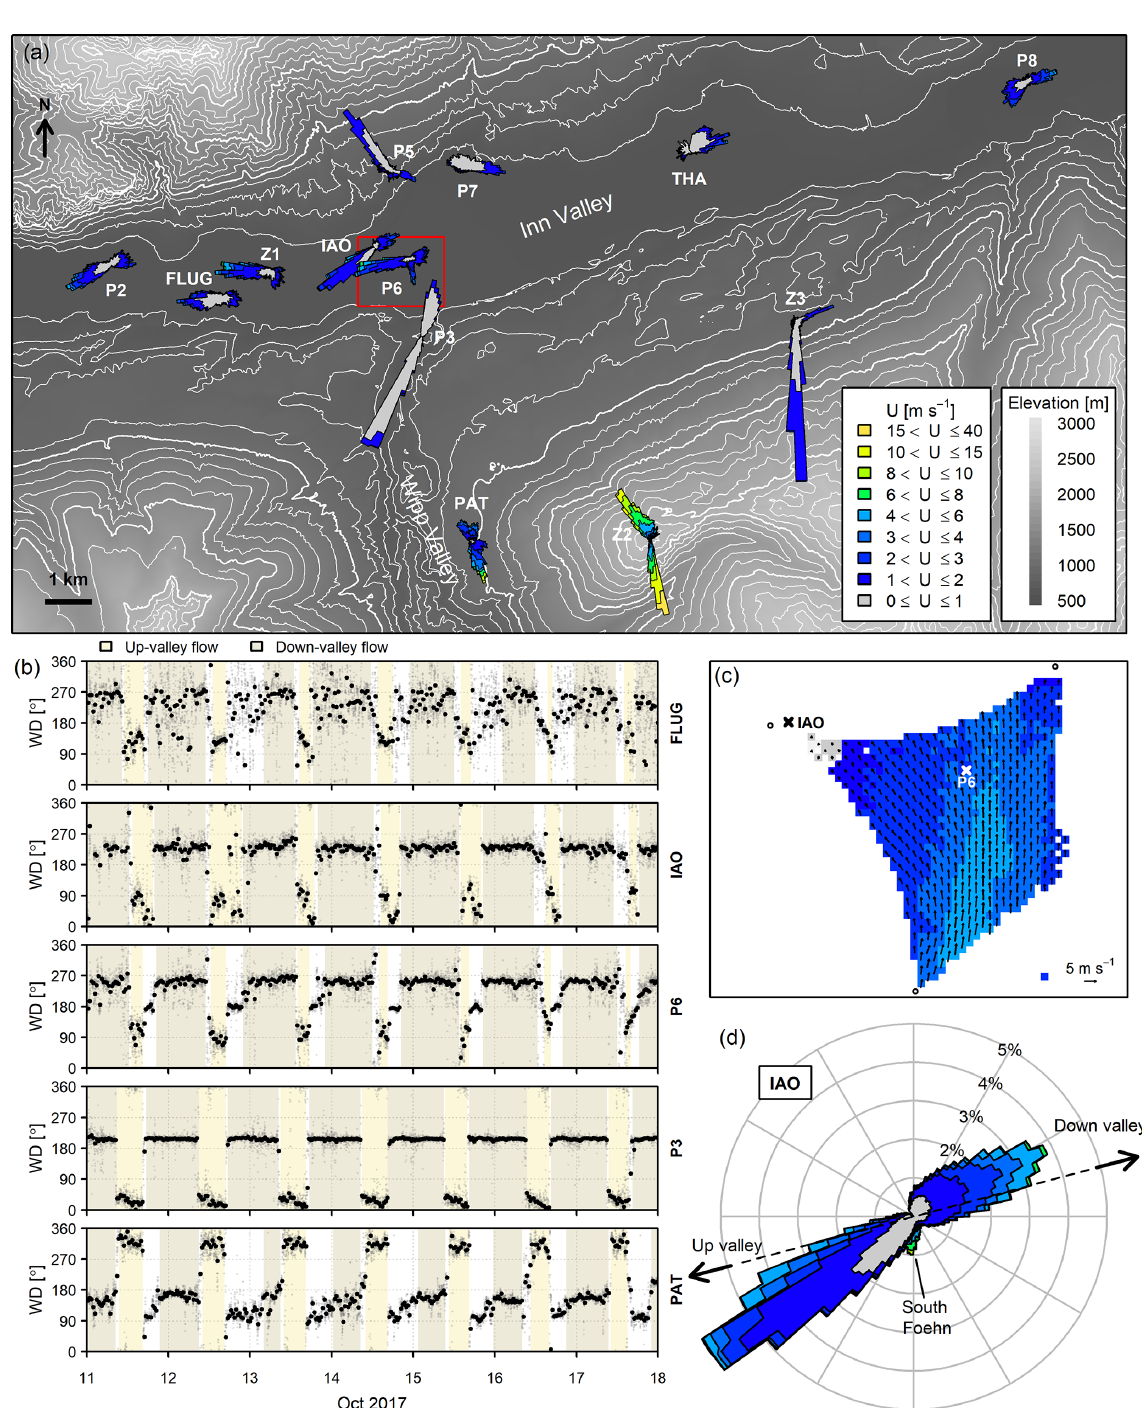
Figure 4. (a) Wind roses for stations in and around Innsbruck during Autumn 2017 (all available 30min data for September–November 2017) overlaid on a digital elevation map (data source: Amt der Tiroler Landesregierung, Abteilung Geoinformation) with thin/thick contours at 100/500m intervals. (b) Time series of wind direction for selected sites for the mostly clear-sky period of 11–18 October 2017, with the up-valley and down-valley flow shaded. The 30min data are shown in black and 1min data in grey. (c) The horizontal wind field (approx. 60m above ground) at 17:50–18:00CET on 16 October 2017, as derived from three Doppler wind lidars (circles) performing coplanar scans (see Haid et al., 2020 for details). Colours/arrows indicate wind speed/wind direction; points outside the coplanar field of view are left white. The area shown in panel (c) corresponds to the red box in panel (a) and is about 1.8km × 1.5km. (d) Wind rose for IAO during the study period (1 May 2017–30 April 2021). The black line indicates the approximate orientation of the Inn Valley axis at IAO, with the up- and down-valley directions marked. The colour scale for wind speed in panels (c) and (d) is the same as in panel (a) . https://doi.org/10.5194/acp-22-6559-2022 Atmos. Chem. Phys., 22, 6559–6593,